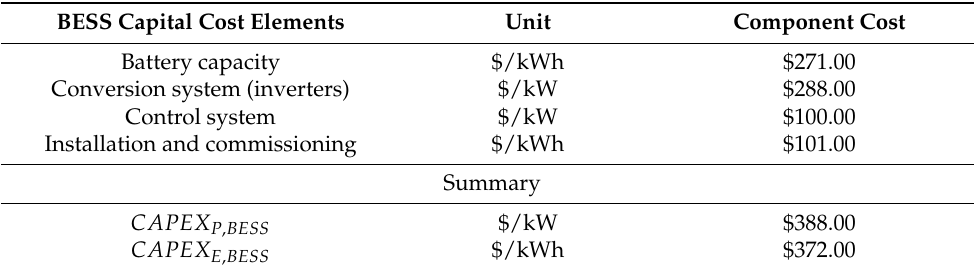
Table 2. BESS capital cost per unit of power and per unit of